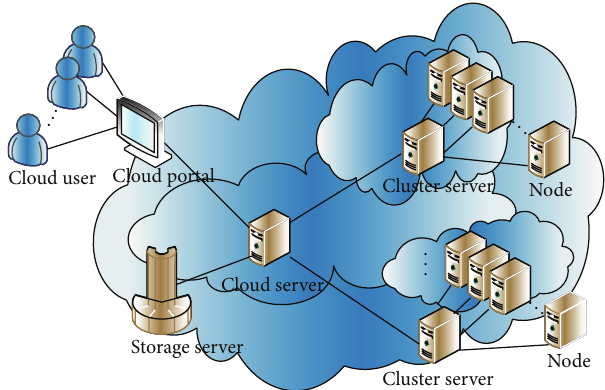
Figure 1: Cloud computing environment.